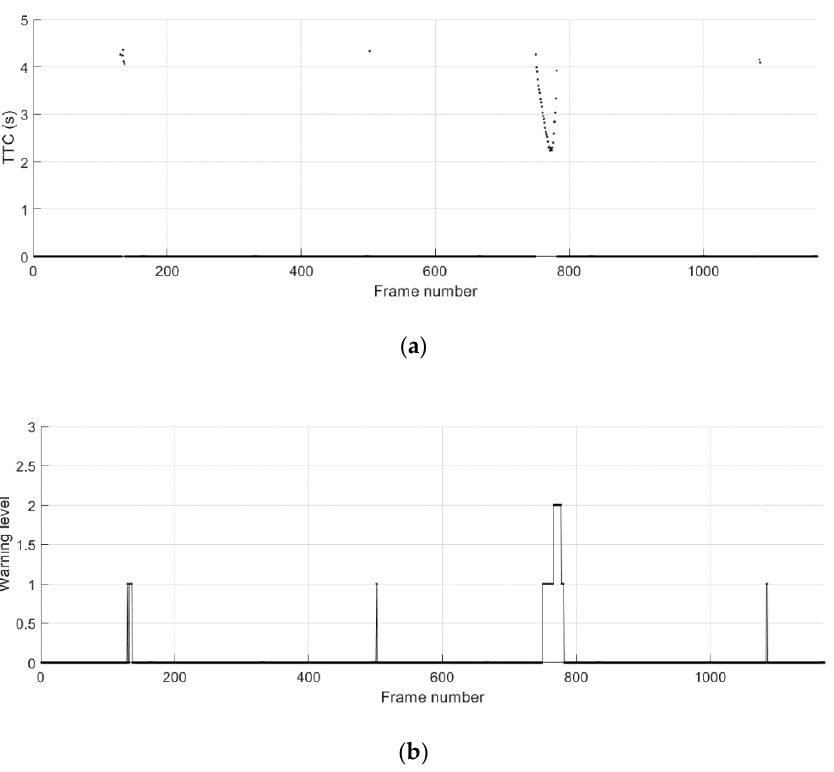
Figure 13. Relative distance to the remote vehicle during the cut-in driving scenario 1. ( a ) Ground truth longitudinal distance; ( b ) ground truth lateral distance; ( c ) absolute error for longitudinal distance estimates; ( d ) absolute error for lateral distance estimates.